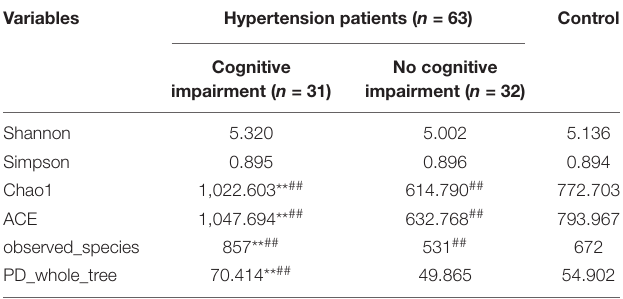
TABLE 3 | Comparison of alpha diversity.